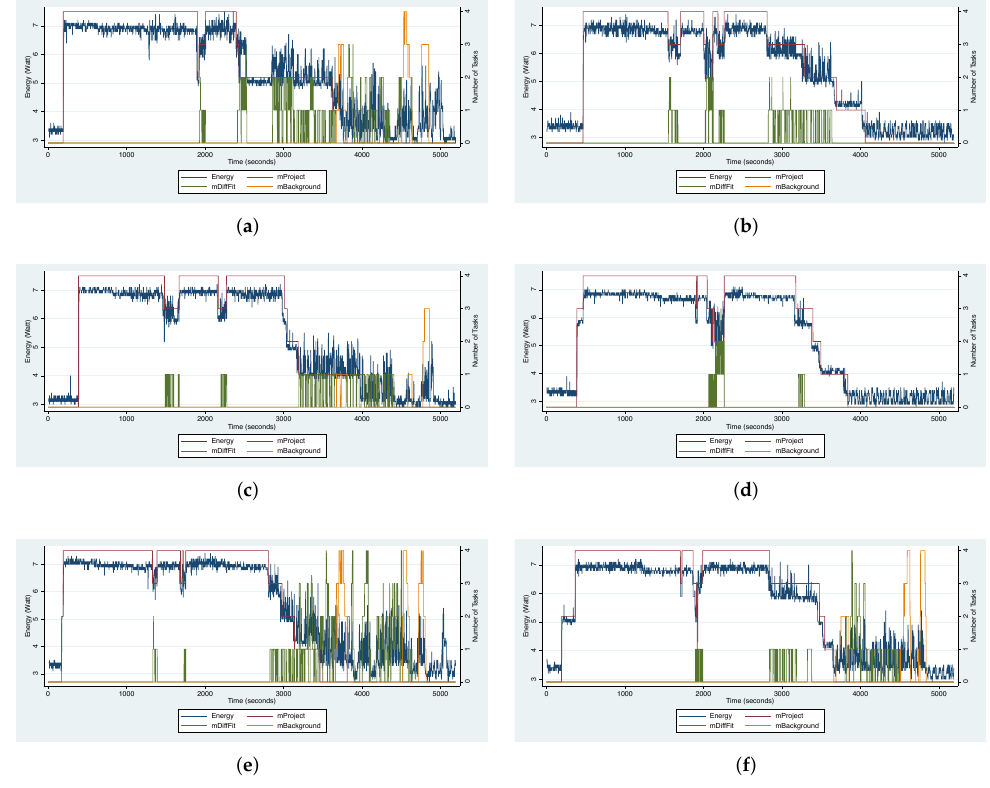
Figure 9. Execution of a Montage 1.0 degree workflow on 6 node cluster: ( a ) Node